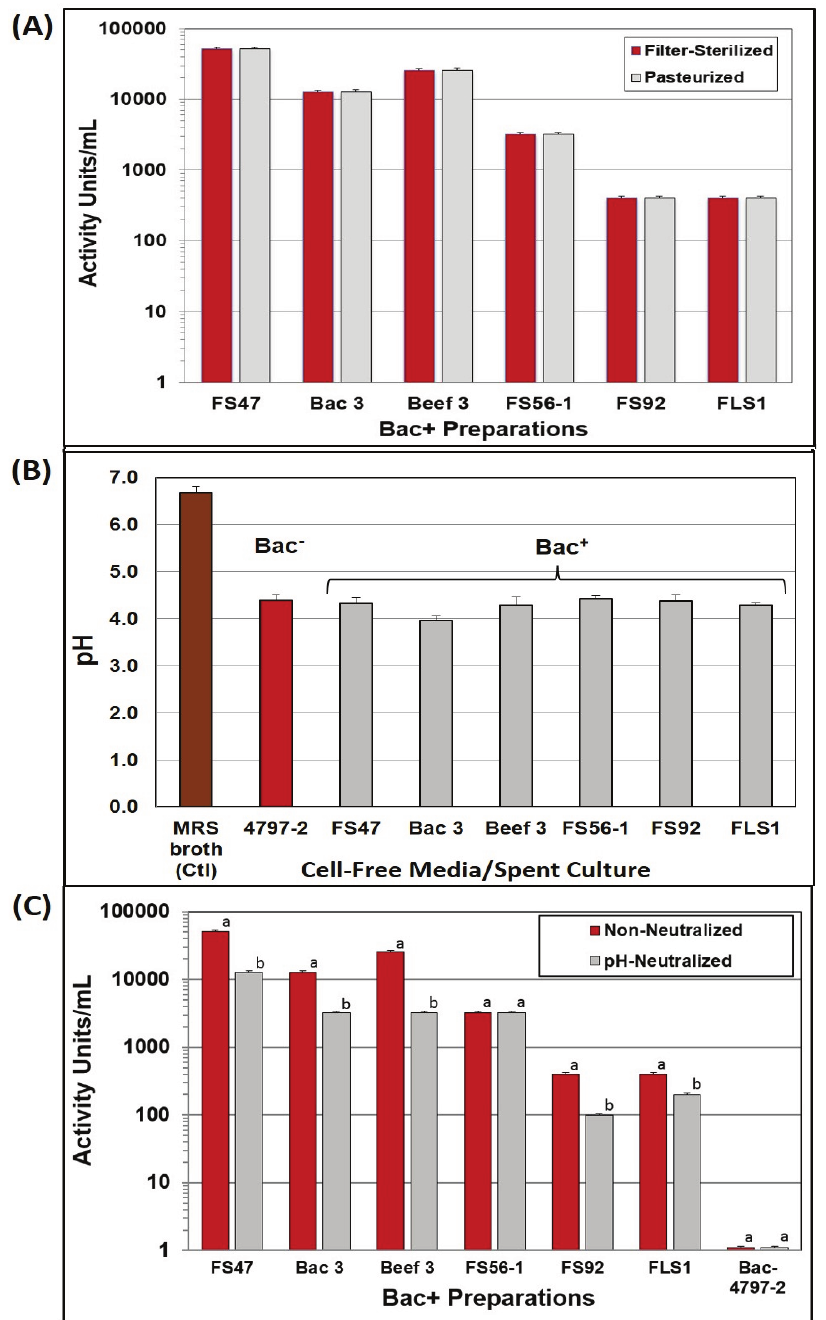
Figure 1. Treatment of culture supernatants produced by Lb. delbrueckii 4797-2 (Bac (cid:2) ) and Bac + strains: Lb. curvatus FS47, P. acidilactici Bac3, Lb. curvatus Beef3, En. faecium FS56-1, En. thailandicus FS92, and Lc. lactis FLS1. ( A ) Comparison of bacteriocin activity after filter sterilization or heat pasteurization; ( B ) The pH of MRS broth media before inoculation and after overnight growth of various strains used in this study; ( C ) Bacteriocin activity titers of cell-free supernatants against L. monocytogenes 39-2, before and after neutralization. Treatments with the same culture supernatant that have different lower case letters are significantly different ( p < 0.05); treatments with the same lowercase letter are not significantly different ( p > 0.05). No differences were found in duplicate replications of samples in ( A ) and ( C